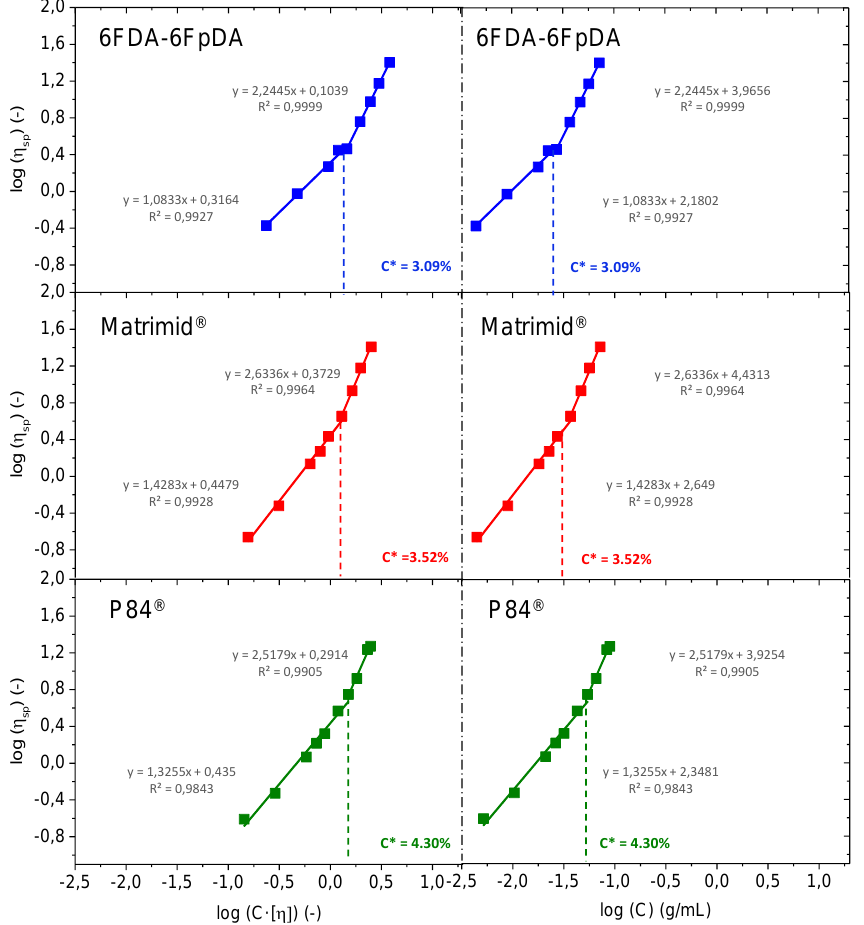
Figure 5. Overlap concentration ( C *) for the polymer solutions studied obtained from the representation of log 𝜂 𝑠𝑝 as a function of log(C [𝜂] ) ( left side) and as function of log(C) ( right side). The aging effect is more pronounced for polymers with higher free volume, i.e., the more permeable polymers, such as 6FDA-6FpDA. The origin of the aging effect is related to the relaxation processes that occur in glassy polymers. After the membrane casting, the solvent is continuously evaporating, and this evaporation changes and relaxes, continuously, the polymer conformation. Due to this relaxation, the polymer chains are “arriving” to the low energy level , and the fractional free volume is reduced, leading to a less permeable material [40]. This situation is fostered by thermal treatment at elevated temperatures, leading to polymers with more stable separation properties. The effect of selective layer aging is graphically demonstrated in Figure 6, where the normalized H 2 permeance over time for 6FDA-6FpDA membranes, not treated and thermally treated in a vacuum oven, are shown. While the untreated membrane showed a decrease of the H 2 permeance over time, the thermally treated sample presented a constant permeance value. This indicates that, after thermal treatment at 200 °C, the permeation properties are much more stable with time. Therefore, all the films were thermally treated at 200 °C under vacuum for 12 h before further characterization.